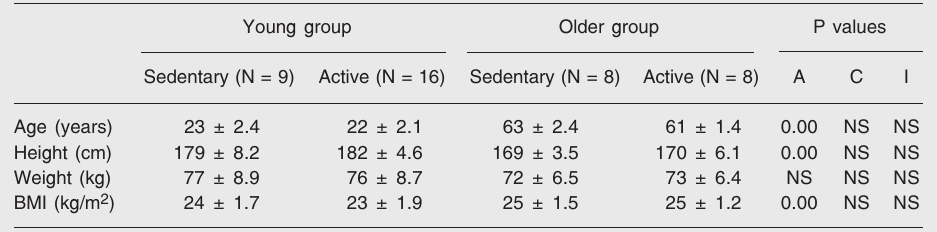
Table 1. Comparison of the anthropometric data for all groups